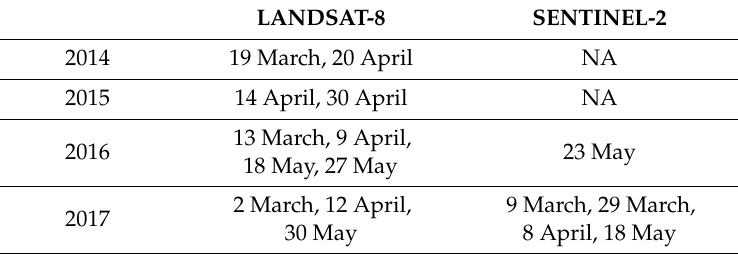
Table 1. Acquired dates of Landsat-8 and Sentinel-2